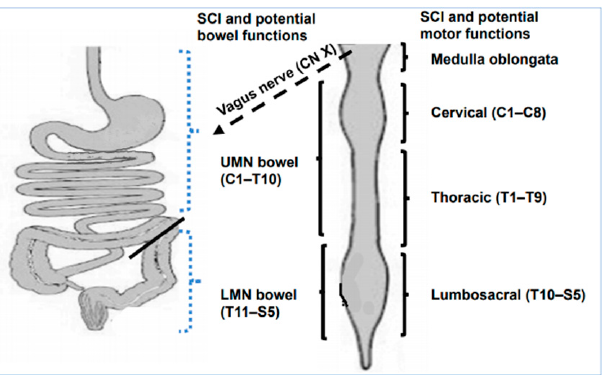
Figure 1. Schematic diagram of the gastrointestinal tract innervation and potential functional bowel and motor outcomes.